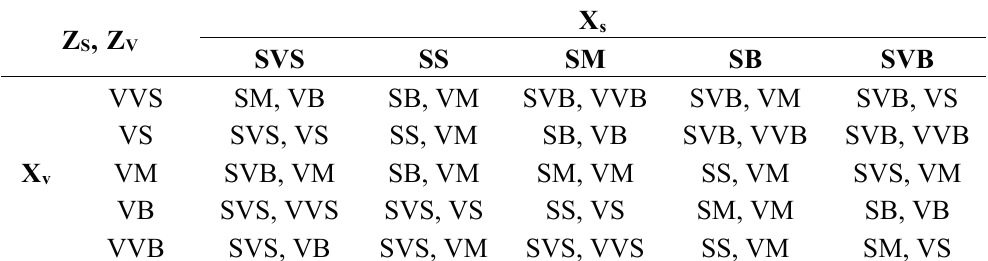
Table 5. Rule table of environmental factor fuzzy